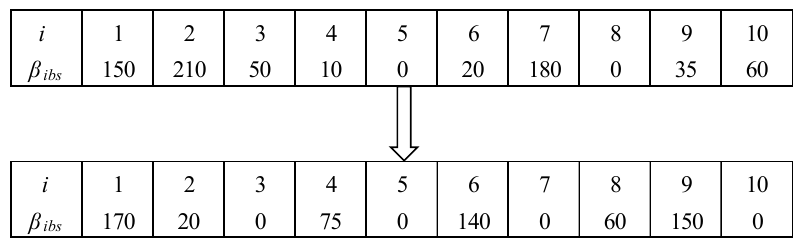
Figure 3. The coding method of the key decision variables.